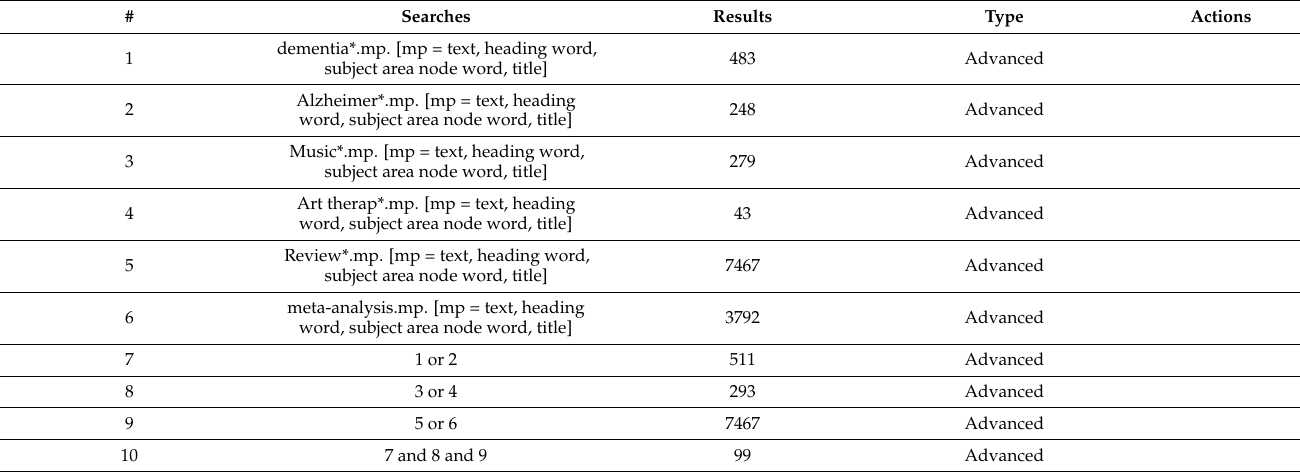
Table A1. The Joanna Briggs Institute EBP database—11 January